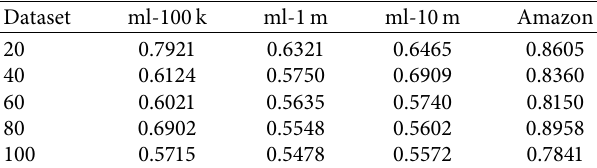
Figure 5: Development trend of martial arts from 2015 to 2020. Table 2: Specific RMSE values for